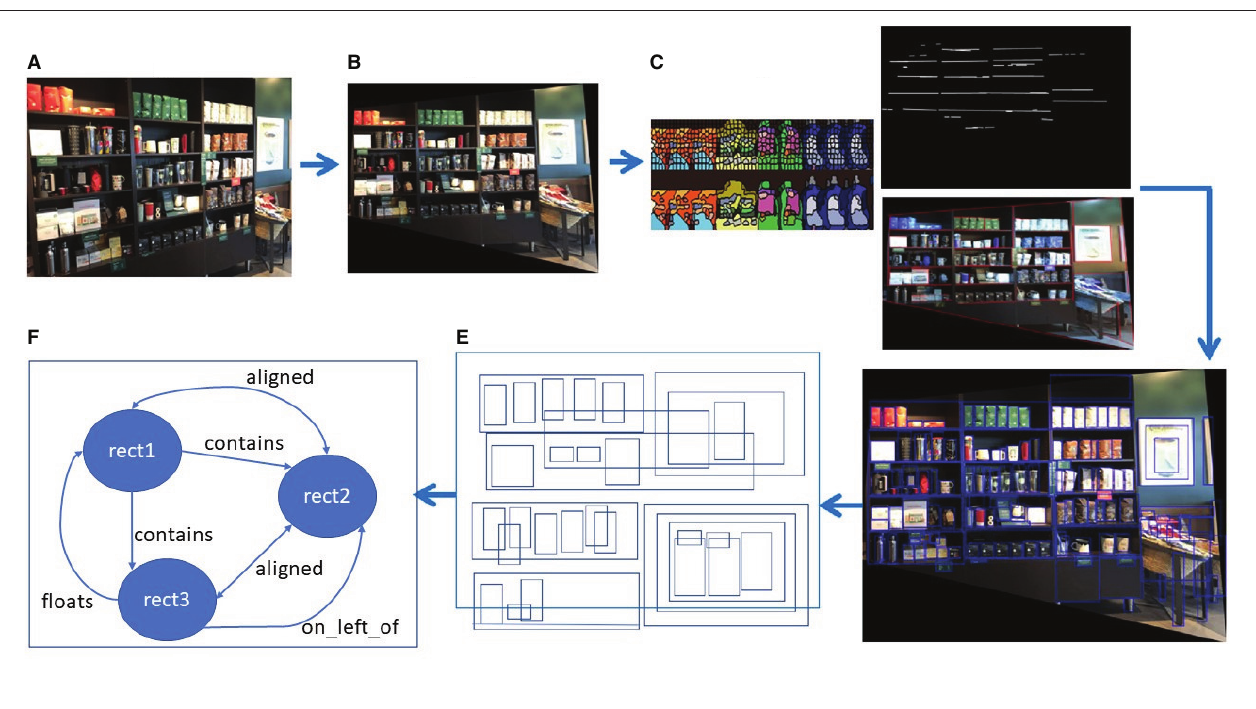
FIGURE 2 | Flow of retail use case for metamodel (from Latapie et al., 2021). (A) Raw input from sensor data services. (B) Rectified input from data structuring services. (C) Unsupervised clustering and line detection from image processing services. (D) Bounding boxes from sensor data analytic services. (E) 2D world of rectangles. (F) Symbolic data and knowledge graph from spatial semantics